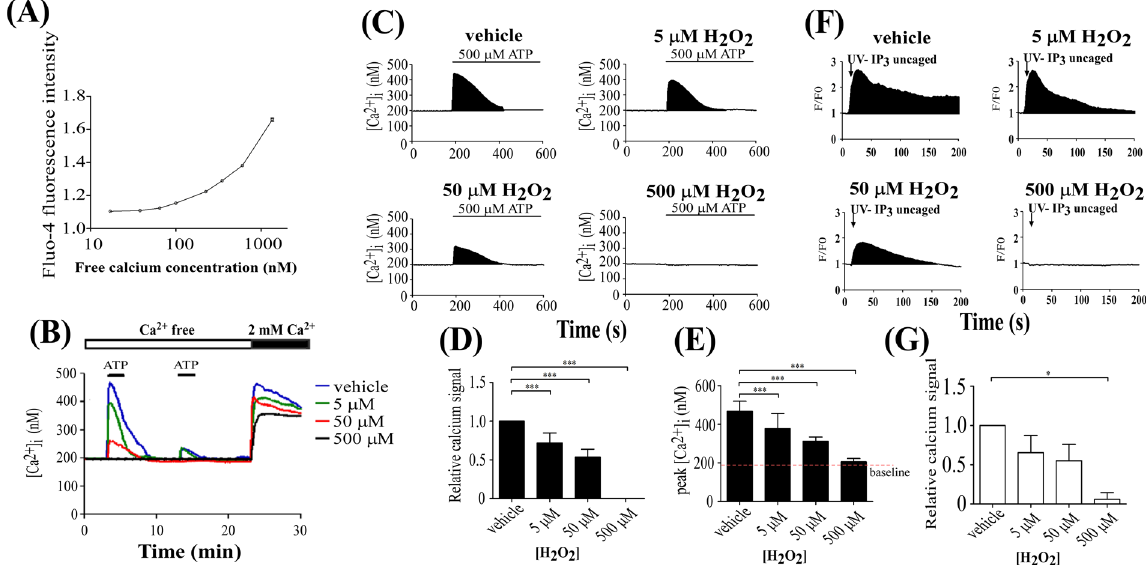
Figure 2. H 2 O 2 dose-dependently inhibited Ca 2 + signaling in KC induced by ATP or IP3 uncaging. ( A ) Ca 2 + calibration curve. Horizontal axis indicates the free concentration of Ca 2 + ([Ca 2 + ] i ) in standard buffer solution. Vertical axis indicates the ratio of Fluo-4 fluorescence intensity relative to that of baseline fluorescence. ( B ) Effect of H 2 O 2 on ATP-induced Ca 2 + signal. Ca 2 + imaging analysis of the ATP-induced Ca 2 + response after 30 min pretreatment with vehicle (blue), 5 μ M (green), 50 μ M (red), and 500 μ M (black) H 2 O 2 . Ca 2 + signals represent the mean value of 20 cells. Twenty-three minutes after two applications of ATP (small black bars) at 10 min intervals in Ca 2 + -free BSS solution (open bar), CaCl 2 was applied extracellularly (large black bar) to increase Ca 2 + from 0 to 2 mM to open the store-operated Ca 2 + channels (N = 5). ( C ) The Ca 2 + signal from the first simulation with ATP in ( B ) is shown. ( D ) Relative Ca 2 + signals were measured by calculating the black areas under the curves of the intracellular Ca 2 + responses with or without H 2 O 2 treatment in ( C ) ( *** P < 0.005 in D and E). ( E ) Quantification of the peak ATP-induced Ca 2 + elevation for all groups in ( C ). ( F ) Effect of H 2 O 2 on the IP 3 -induced Ca 2 + response. The concentration of H 2 O 2 used is indicated. F/F0 expresses the Fluo-4 fluorescence ( F ) relative to baseline fluorescence (F0), which corresponds to changes in the intracellular Ca 2 + concentration. Uncaging of caged-IP 3 using UV irradiation released IP 3 molecules in the cell. The black area under the curve indicates the amount of Ca 2 + released by uncaged IP 3 (N = 5). ( G ) The amount of Ca 2 + was calculated by quantifying the black areas under the Ca 2 + curve ( * P < 0.05).